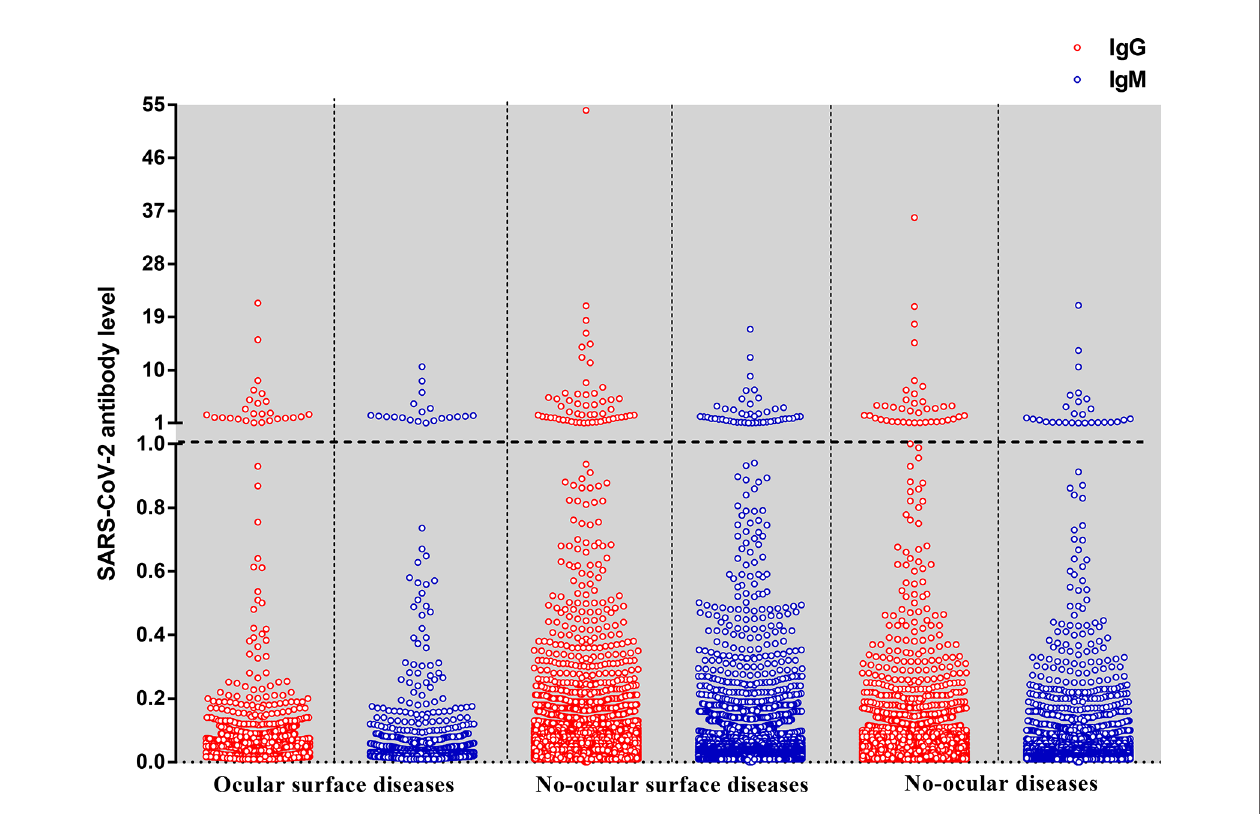
FIGURE 2 | The level of IgG and IgM antibodies against the nucleoprotein and a peptide from the spike protein of SARS-CoV-2 by the type of diseases. Each dot represents the level of IgG (red) or IgM (blue) antibody for an individual. The SARS-CoV-2 antibody level expressed as the ratio is calculated by the chemiluminescence signal divides the cutoff value (S/CO). The dotted line means that the antibody level is at the cutoff value (S/CO=1).